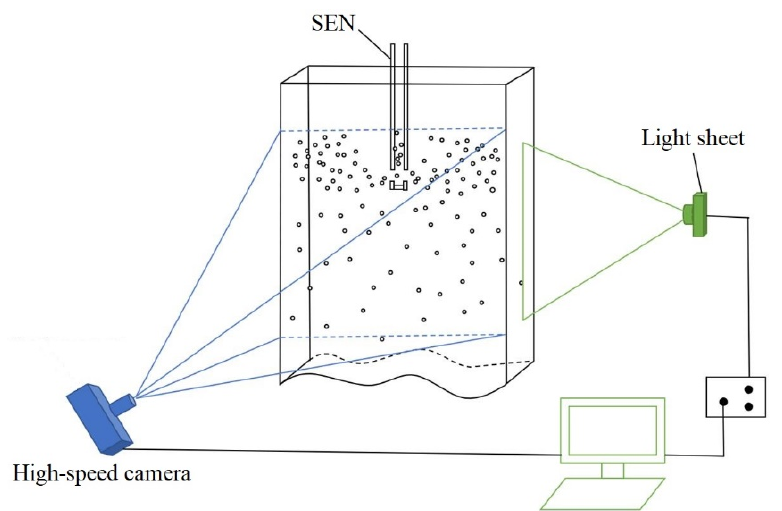
Figure 4. High-speed camera principle.